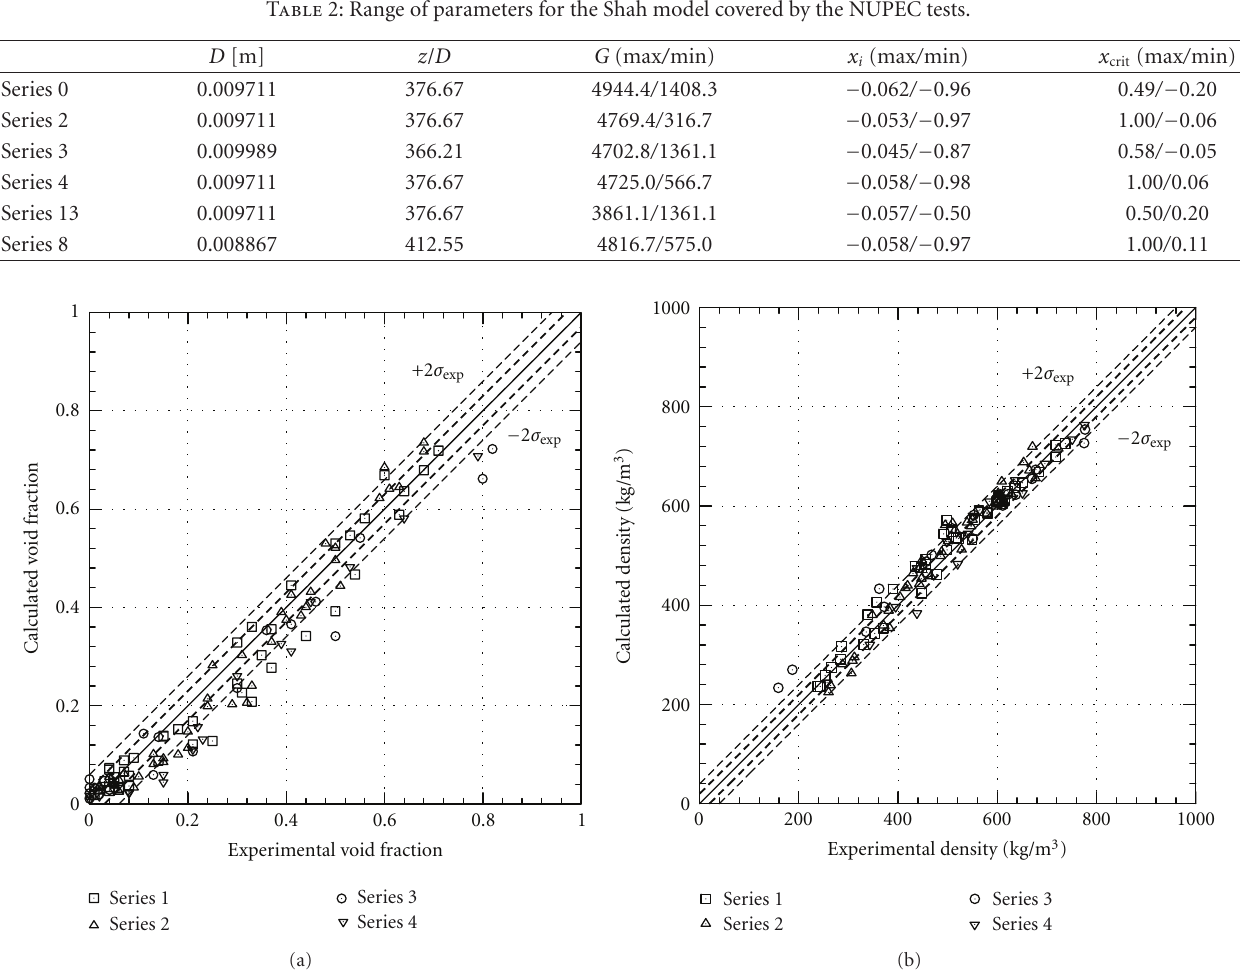
Figure 2: Calculated void fractions (a) and densities (b) versus experimental data for subchannel series 1 to 4 with the Chexal-Lellouche drift